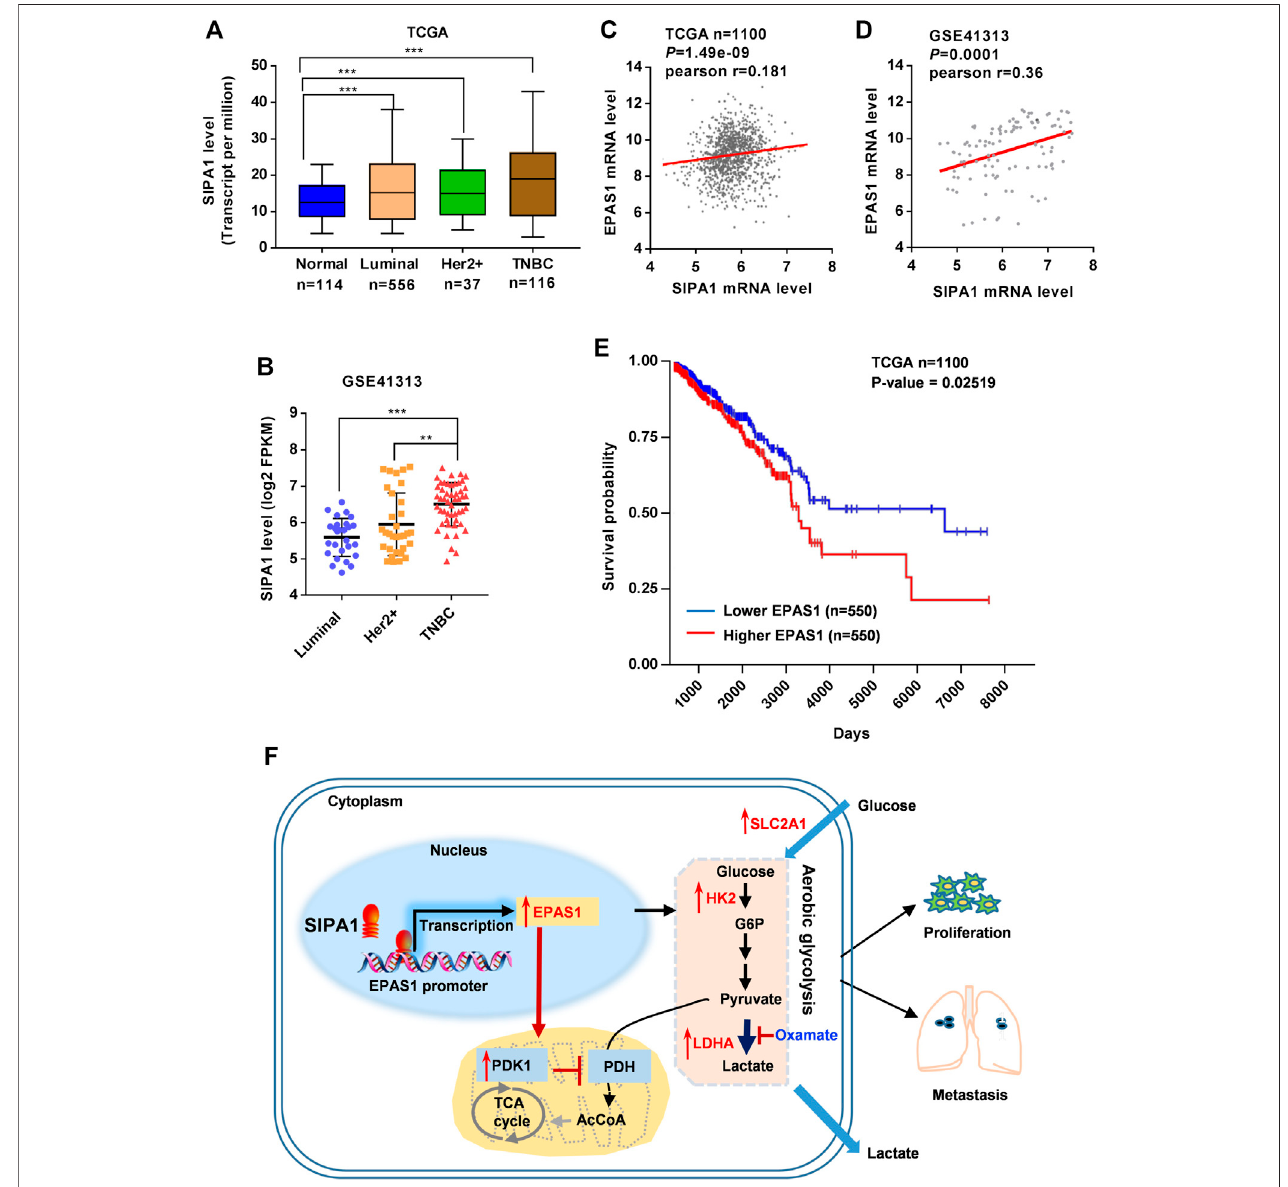
FIGURE 6 | SIPA1/EPAS1 axis is a poor prognosis predictor of breast cancer. (A – B) mRNA level of SIPA1 in breast cancer subtypes in TCGA (A) and GSE41313 dataset (B) . (C – D) The relationship between SIPA1 and EPAS1 was analyzed based on TCGA (C) and GSE41313 datasets (D) . Pearson correlation coef fi cients (Pr) for SIPA1 and EPAS1 gene expression levels were shown. (E) Kaplan-Meier survival analysis for survival probability of breast cancer patient in TCGA according to EPAS1 expression status. The p value was presented using the log-rank test. (F) A proposed diagram for SIPA1-mediated aerobic glycolysis and breast cancer cell